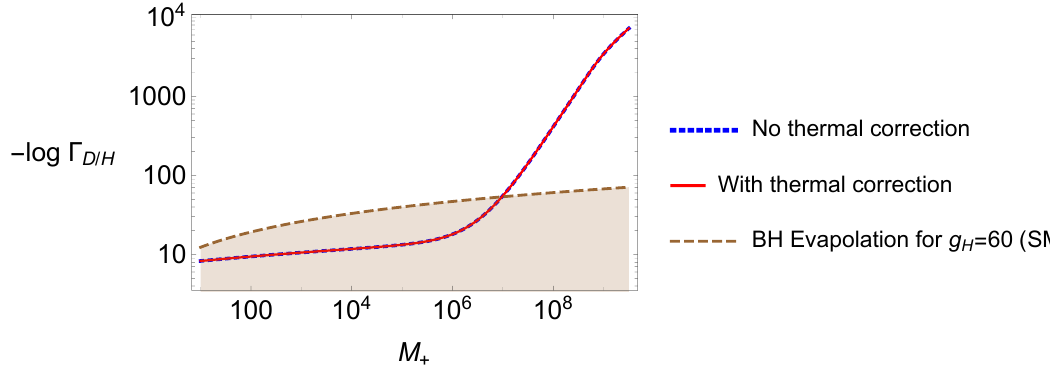
Figure 8 . The bubble nucleation rate for the SM Higgs (cid:12)eld with a BH as a function of the seed BH mass M + is shown. Here we take the potential parameters as (cid:21) (cid:3) = 10 (cid:0) 6 . The blue dotted line indicates the bubble nucleation rate without thermal correction, while red solid line indicates the one with the thermal correction (eq. (4.4)). Brown dashed line represents the BH evaporation rate. The bubble nucleation rate exceeds the BH evaporation rate in the brown region, which means that the Universe would undergo the Higgs vacuum decay for M + < 10 7